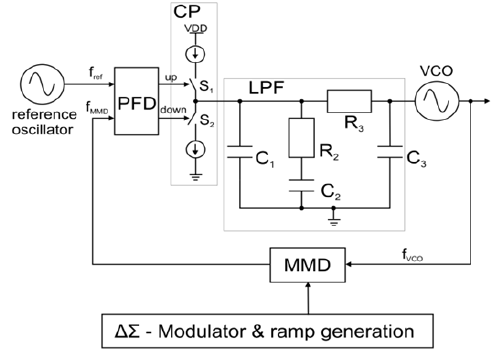
Figure 4. Schematic of the proposed 24 GHz FMCW